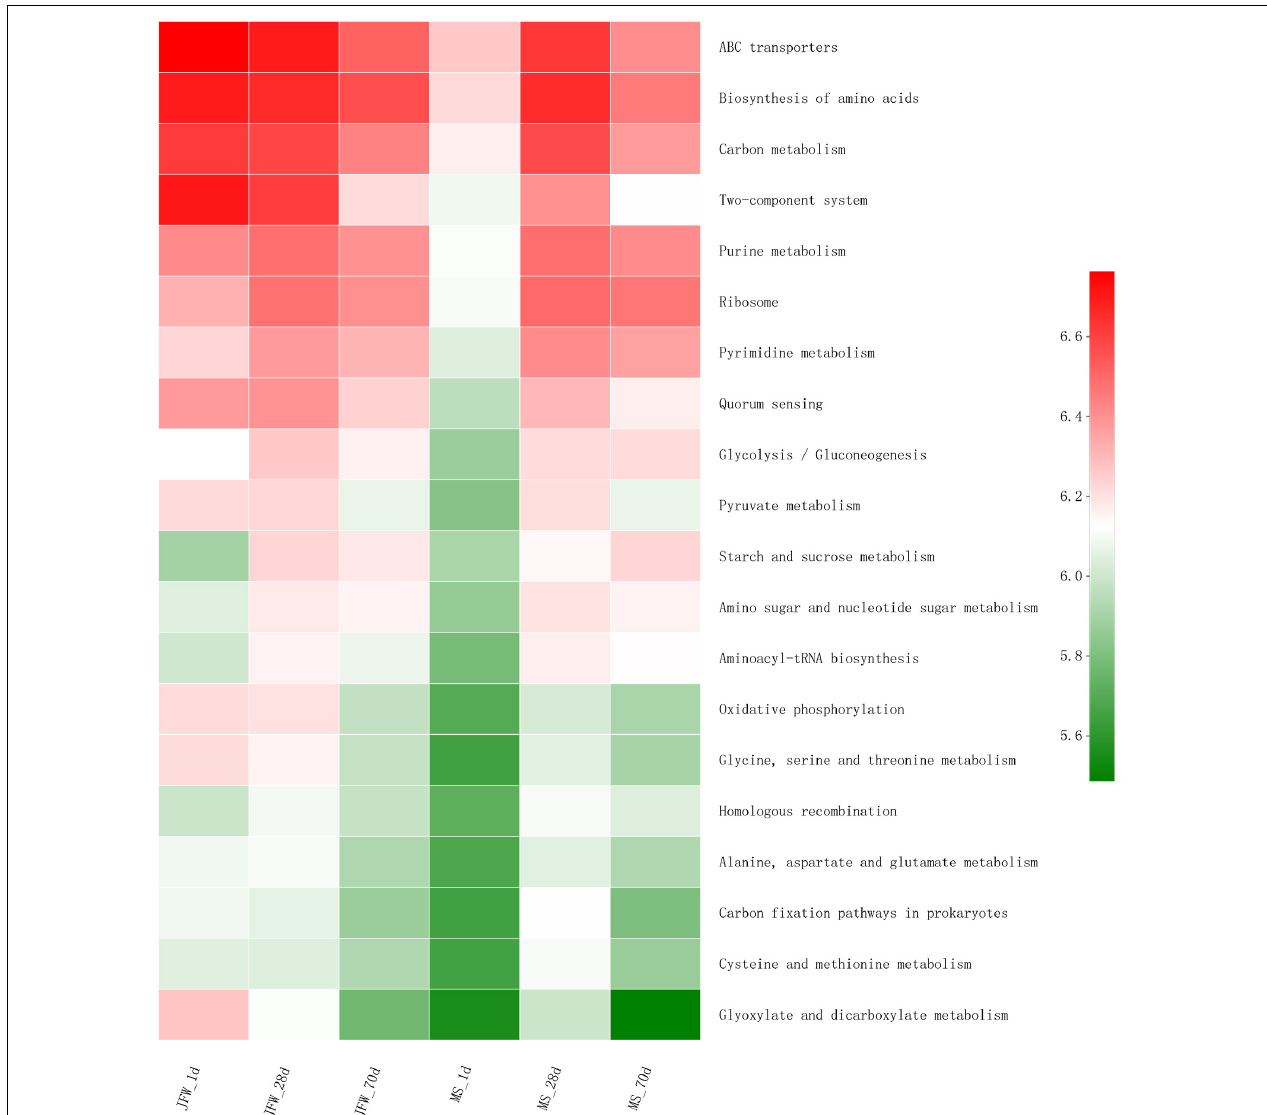
FIGURE 7 | The top 20 KEGG pathway of ileum microbiota in Jinfen White piglets and Mashen piglets.